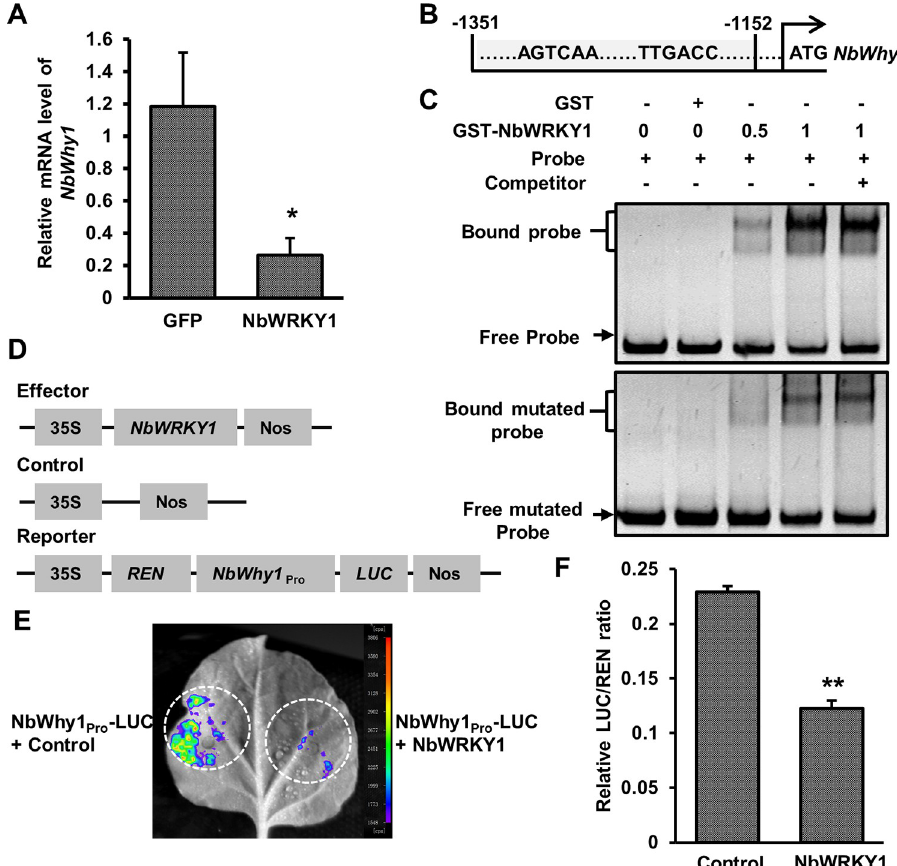
Fig 3. NbWRKY1 binds to the NbWHIRLY1 (NbWhy1) promoter and represses NbWhy1 transcription. ( A) RT- qPCR analysis of NbWhy1 mRNA level in N . benthamiana plants transiently overexpressing NbWRKY1. NbGAPDH was used as an internal control. Mean and standard deviation of three independent plants are shown. Asterisk indicates a significant statistical difference between two treatments at p < 0.05 based on Student’s t test. (B) Schematic depiction of the putative W-box elements found in the promoter region of NbWhy1 . The region from -1351 to -1152 nucleotides upstream of the ATG codon of NbWRKY1 was used for electrophoretic mobility shift assay (EMSA). (C) EMSA showing the specific binding of NbWRKY1 to the NbWhy1 promoter. Purified GST or GST-NbWRKY1 protein from Escherichia coli extracts was incubated with 20 ng of DNA probes. Poly (dI-dC) was used in excess amounts (100-fold) as non-specific competitor. The lower panel indicates the mutation of W-box in the probe. (D) Schematic depiction of the transient luciferase reporter and effector constructs. (E) NbWRKY1-mediated repression of transcription. Expression of luciferase (LUC) reporter was driven by the NbWhy1 promoter ( NbWhy1 Pro ). The luciferase fluorescence in the infiltrated N . benthamiana leaves was detected by the live molecular imaging system. 35S, the 35S promoter of cauliflower mosaic virus; REN, Renilla luciferase; Nos, Nos terminator. (F) Measurement of relative LUC/REN ratio in N . benthamiana leaves. Mean and standard deviation of three independent replicates are shown. Double asterisks indicates a significant statistical difference between two treatments at p < 0.01 based on Student’s t test.